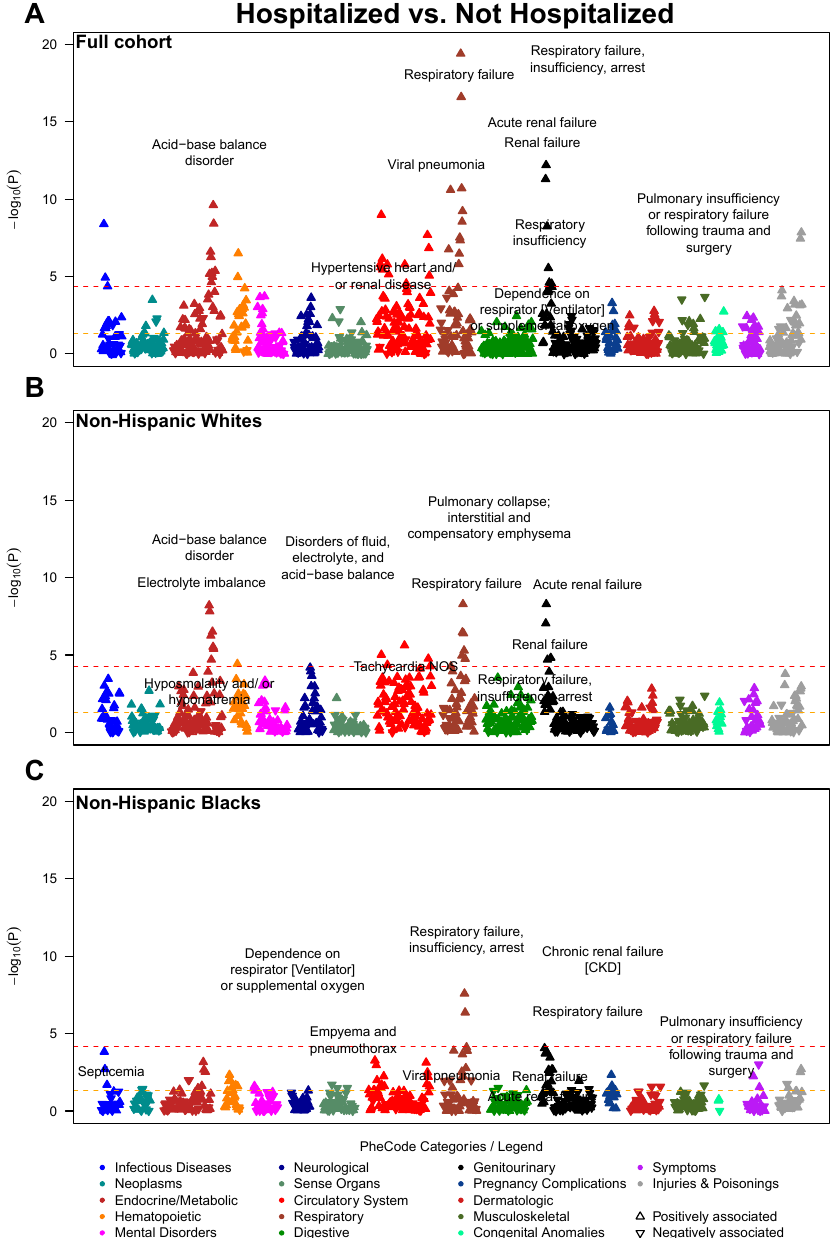
Figure 1. Manhattan plot showing the phenome-wide association between disease conditions and hospitalization for COVID-19. Models are adjusted for age, sex, race (full cohort only), and three census tract-level socioeconomic indicators: proportion with less than high school education, proportion unemployed, and proportion with annual income below the federal poverty level. The x -axis are individual disease codes, color-coded by their corresponding disease category as described in the shared legend. The y -axis represents the − log 10 transformed p -value of the association. The dashed, horizontal lines represent the p = 0.05 (in orange) and the Bonferroni corrected p -value (0.05/number of tests; in red). Each point is represented by either an upward triangle indicating a positive association or a downward triangle indicating a negative association. ( A ): Full cohort, ( B ): Restricted to Whites, ( C ): Restricted to Blacks